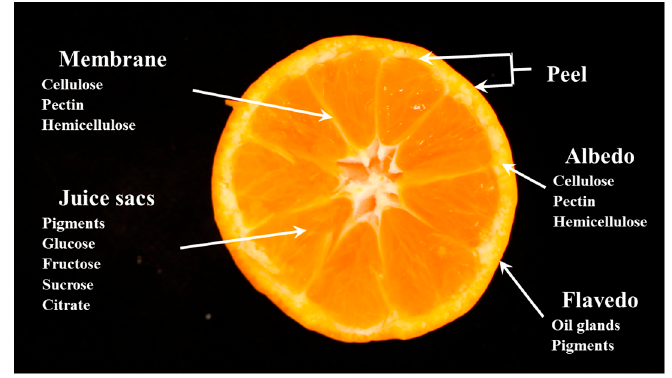
Figure 1. Diagrammatic equatorial cross-section of citrus fruit [15].